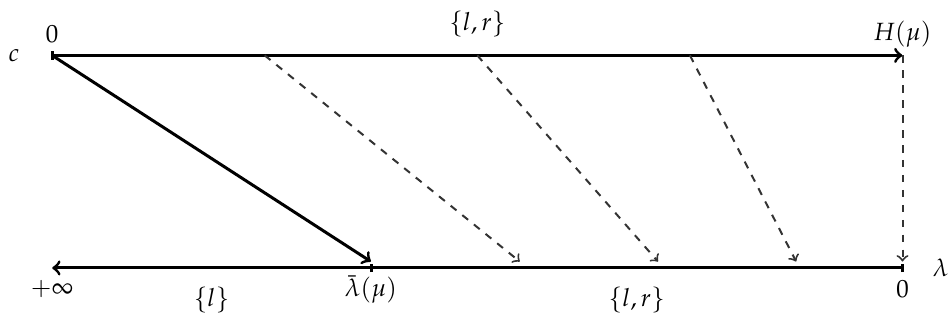
Figure 4. The solution of the example for 0 < µ ≤ γ ∗